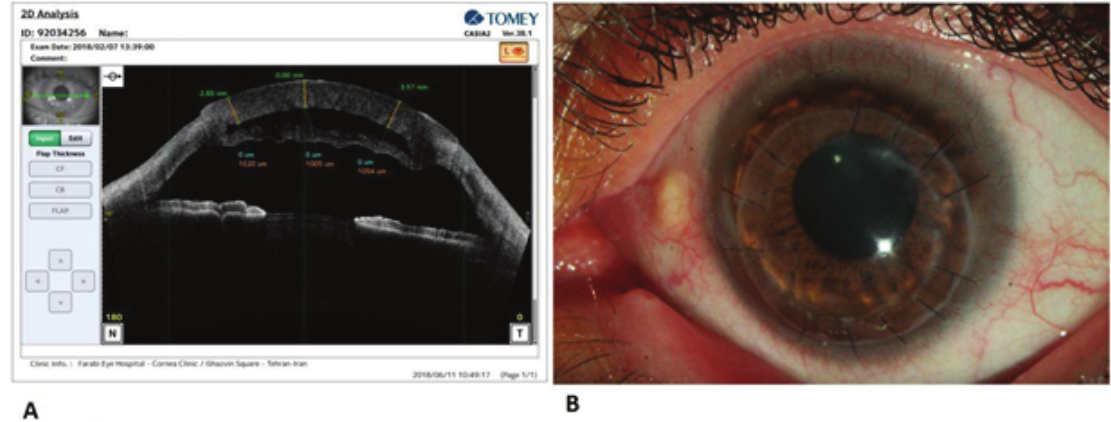
Figure 1. Management of a DM perforation in a DALK case. (A) Anterior segment-OCT (AS-OCT) image showing a double anterior chamber and detached Descemet membrane (double chamber was not resolved after two attempts of gas injection into the anterior chamber). (B) One week after the surgery: Slit lamp photograph shows clear corneal graft with resolved double chamber. Amniotic membrane patch graft is detectable between donor and recipient at the site of Descemet